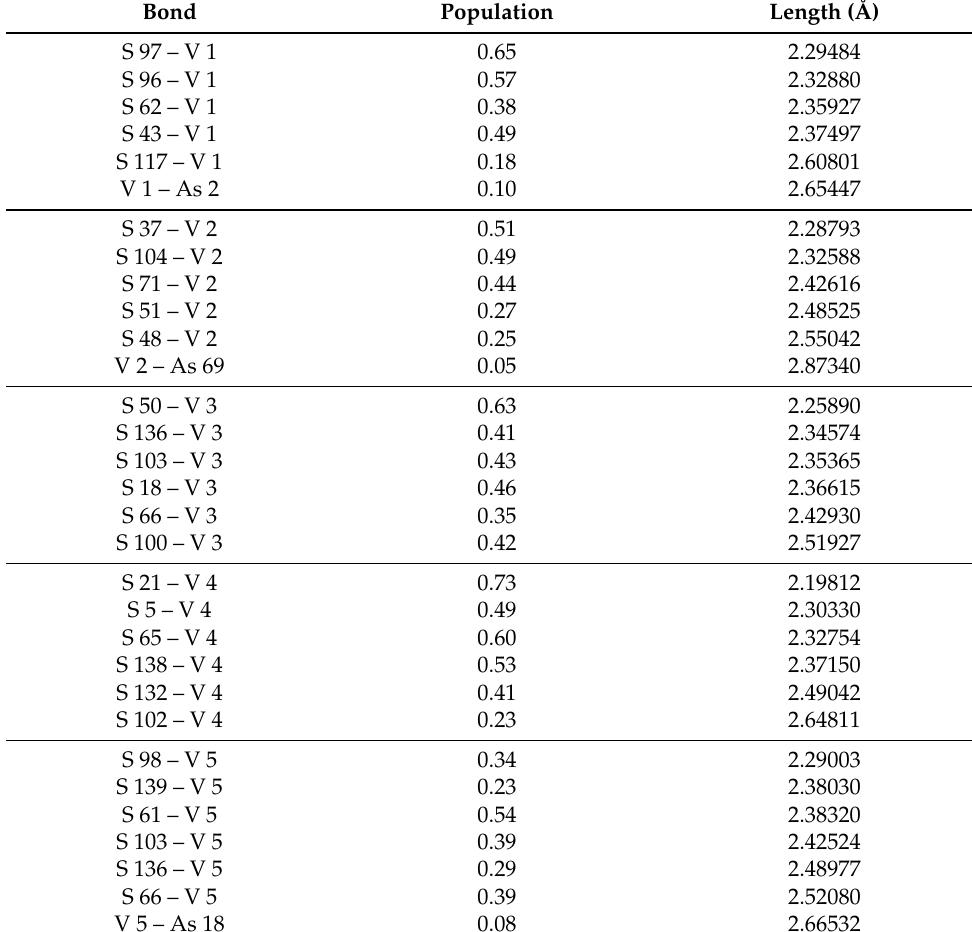
Table A10. Bond populations for mq-GOpt As 2 S 3 :V.